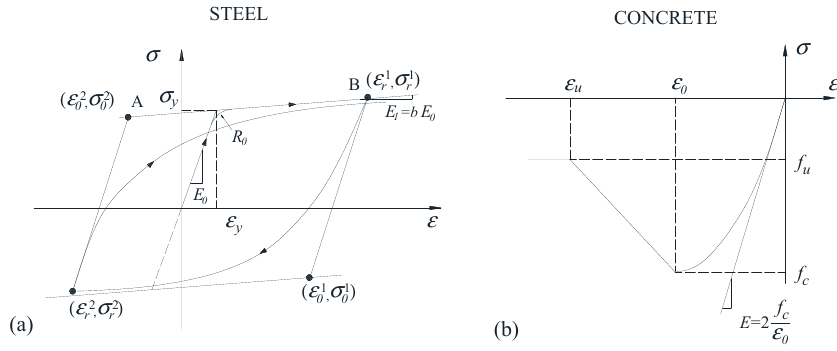
Figure 4. Material constitutive models: ( a ) steel; and ( b ) concrete.